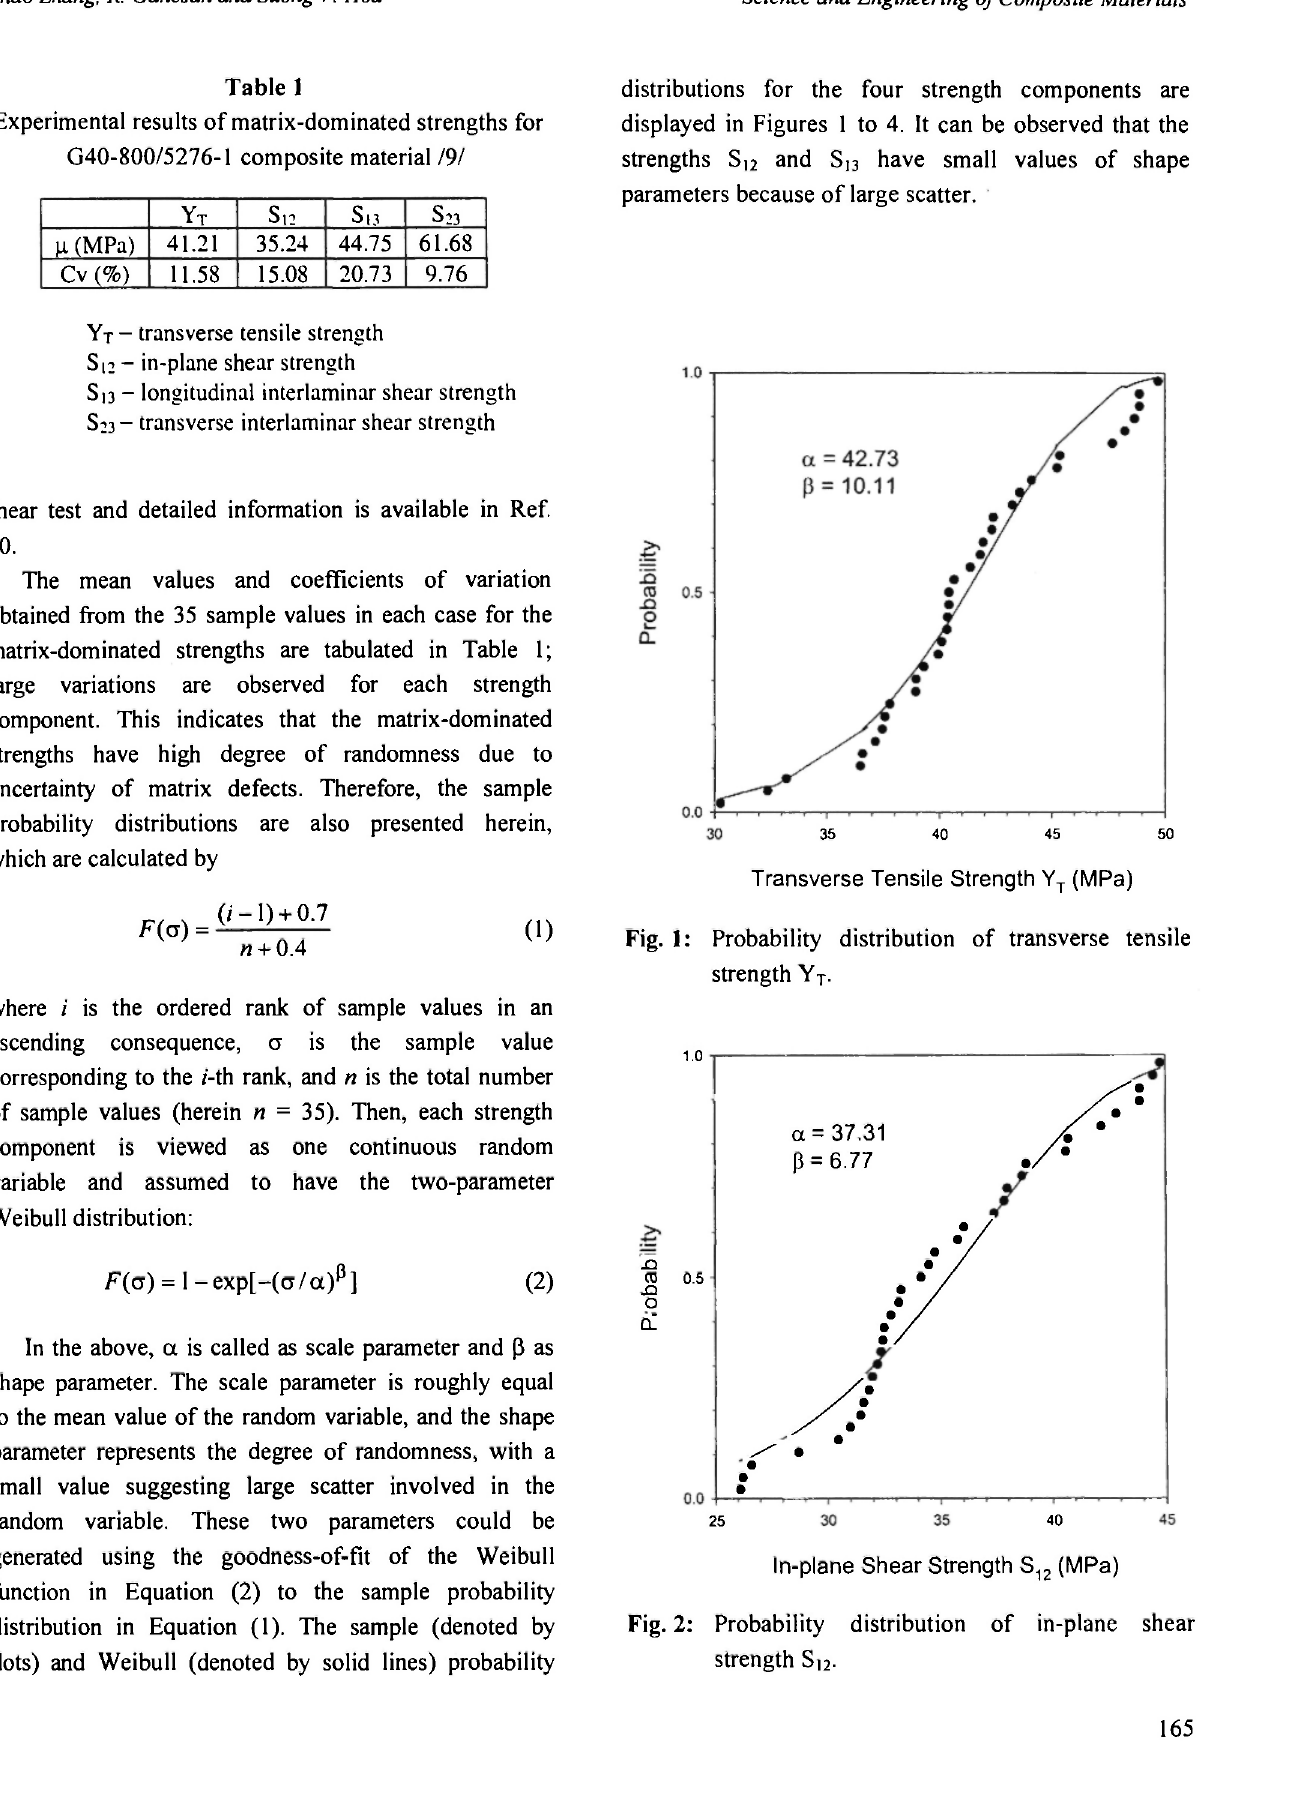
Fig. 2: Probability distribution of in-plane shear strength S i2